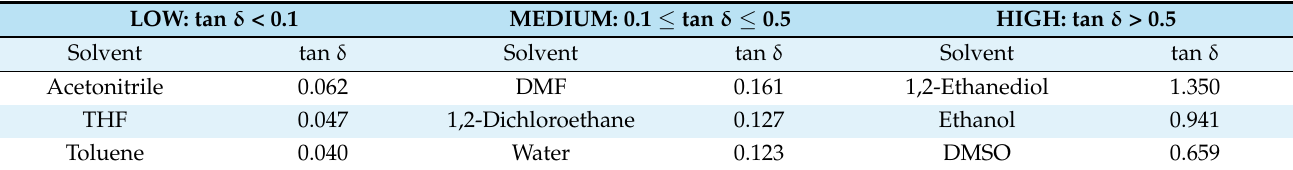
Table 2. Summary of loss tangent (tan δ ) values for solvents commonly used in MW synthesis. LOW: tan δ <